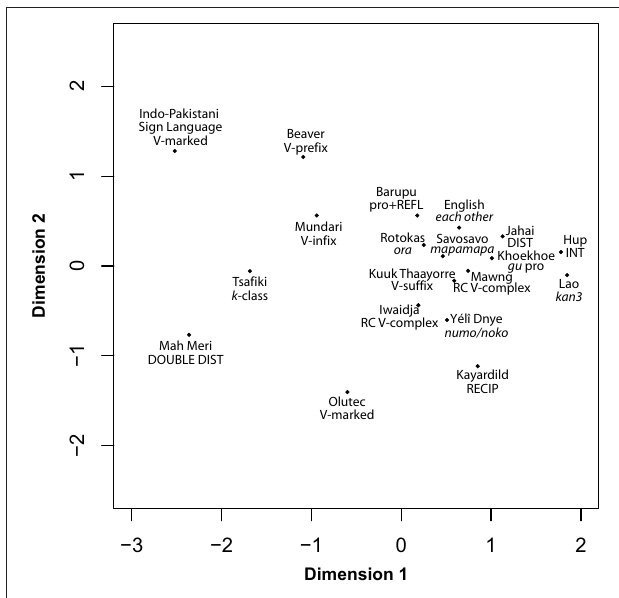
FigurE 9 | Constructional similarity space. The Hup and Lao constructions are the most inclusive and are plotted on the right. As we move toward the left of Dimension 1, constructions become progressively more restrictive. On Dimension 2, Indo-Pakistani Sign Language and Mah Meri are most sharply distinguished, due to their differential extension over clip space (see Figure 8